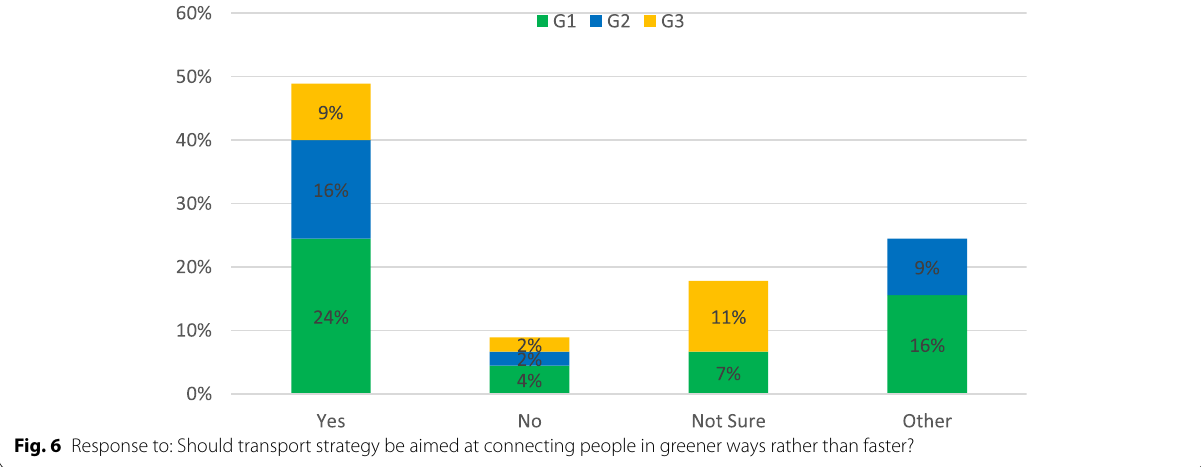
Fig. 6 Response to: Should transport strategy be aimed at connecting people in greener ways rather than faster?